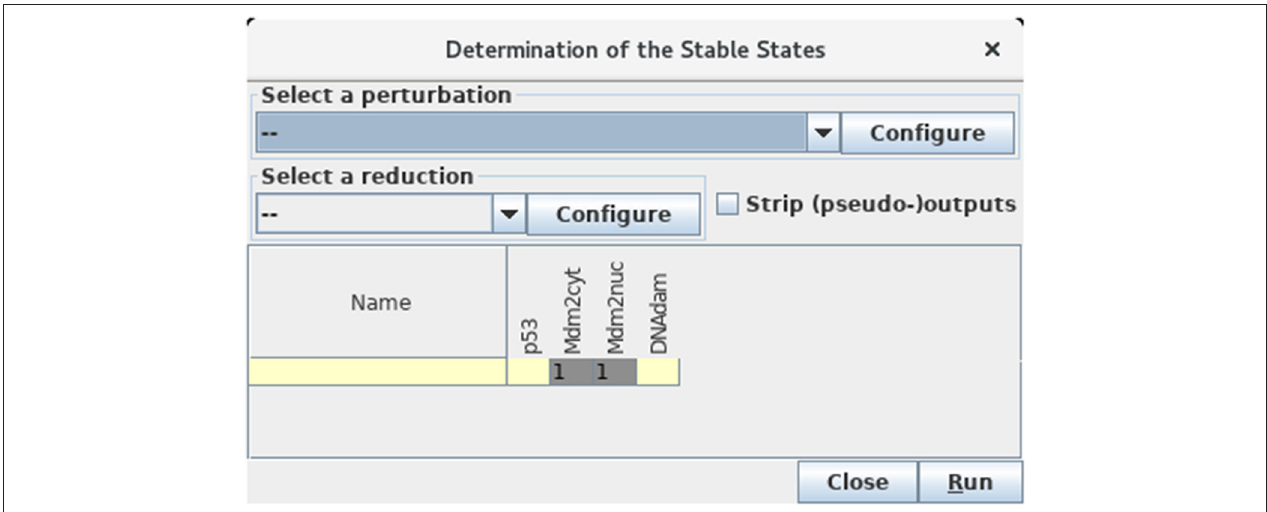
FIGURE 7 | Determination of stable states. This window appears upon selection of Compute stable states with the Tools scrolling menu. After hitting the Run button, GINsim returns all stable states using an efficient algorithm. In the wild type case, we obtain a unique stable state 0110 as shown (yellow and gray cells denote levels 0 and 1,